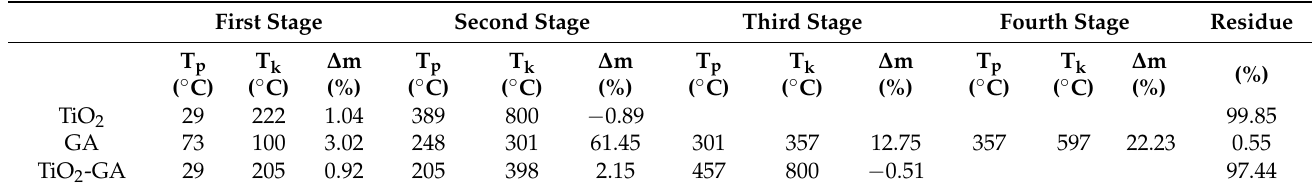
Table 4. Results of thermogravimetric analysis of TiO 2 and TiO 2